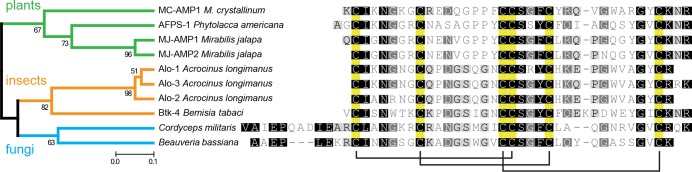
Multiple sequence alignments of knottin-like peptides.The peptide (Mc-AMP1) from the common ice plant was used for ectopic expression and showed sequence similarities to other peptides from plants (all within the Caryophyllales) insects (Coleoptera; Hemiptera) and fungi (Hypocreales). Sequences were retrieved from GenBank and signal peptides were removed using the SignalP 4.1 Server before alignment in Geneious version 6.0.5 (http://www.geneious.com) using the ClustalW algorithm. Accession numbers: Mc-AMP1 [AF069321], MJ-AMP2 [U15539], MJ-AMP1 [U15538], AFPS-1 [AF048745], Alo-1 [P83651], Alo-2 [P83652], Alo-3 [P83653], Btk-4 [ABC40572], C. militaris antifungal_toxin [XP_006665522], B. bassiana hypothetical protein [XP_008602399].